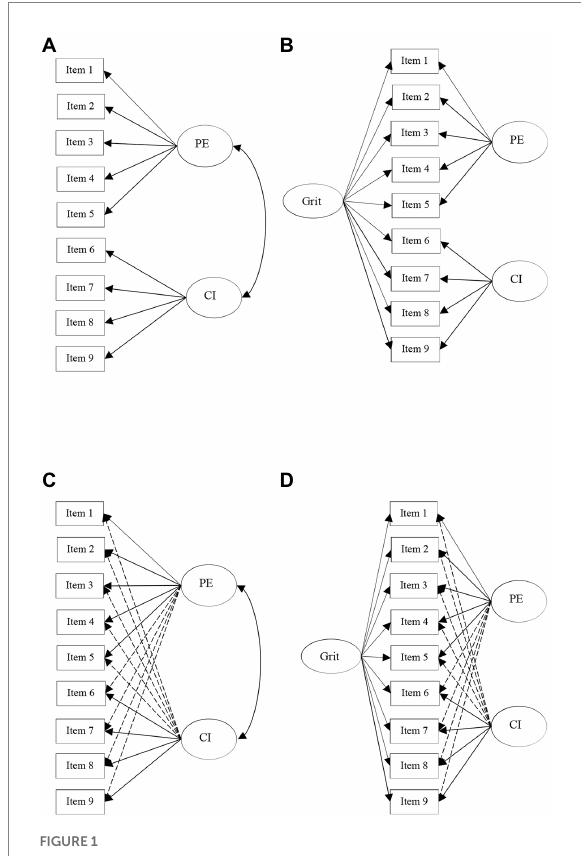
FIGURE 1 Four measurement models of L2 grit, A = CFA model; B = bifactor CFA model; C = ESEM model; D = bifactor ESEM model; PE = perseverance of effort; CI = Consistency of interest.